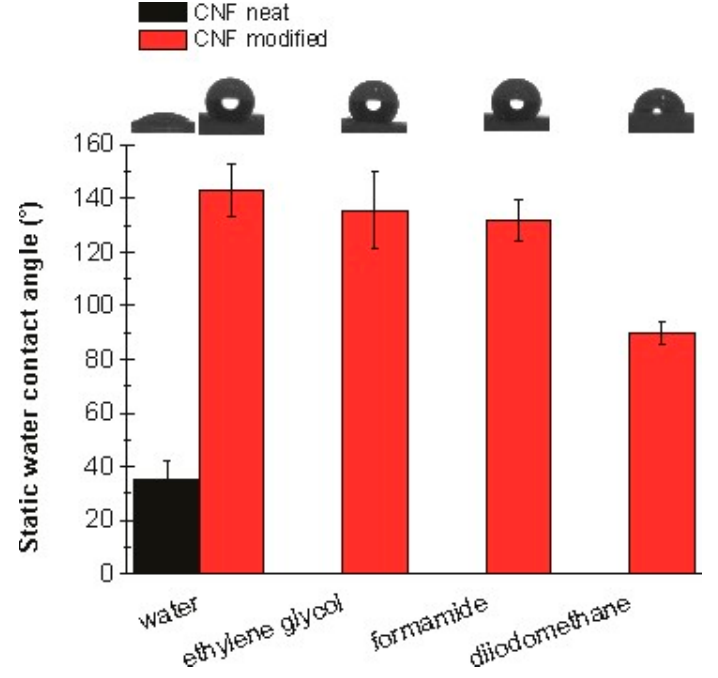
Figure 9. Static contact angles of water, ethylene glycol, formamide, and diiodomethane on neat CNF aerogel and silane-modified CNF aerogel.